Question: Identify the chart type used in this figure.
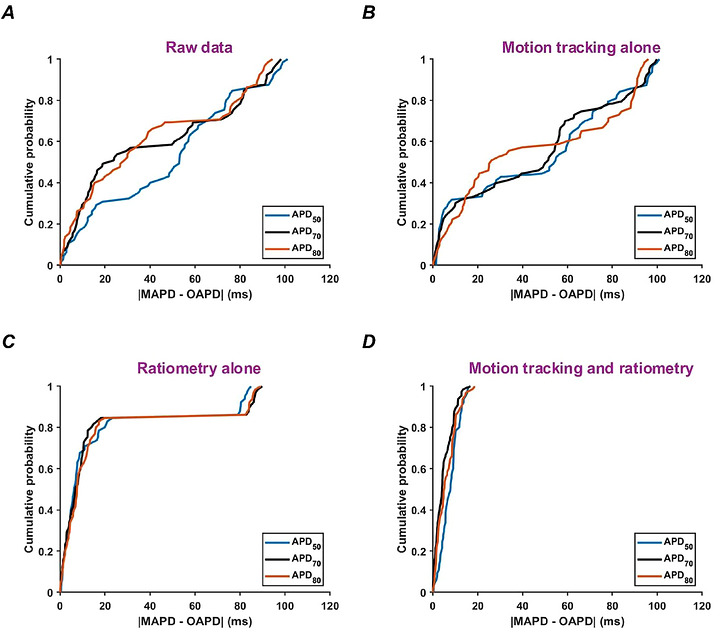
Answer: line